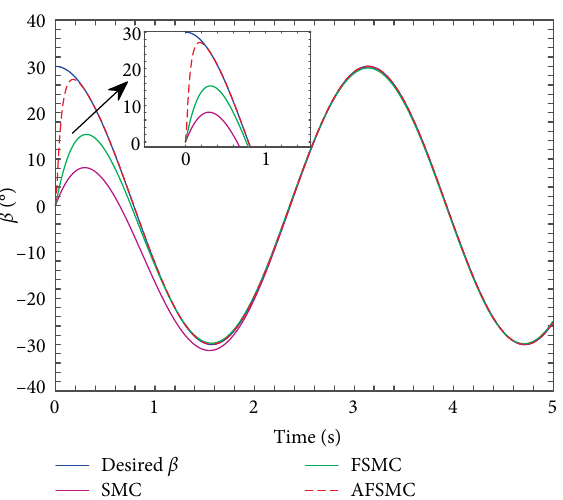
Figure 10: Trajectory tracking in z direction of three controllers.